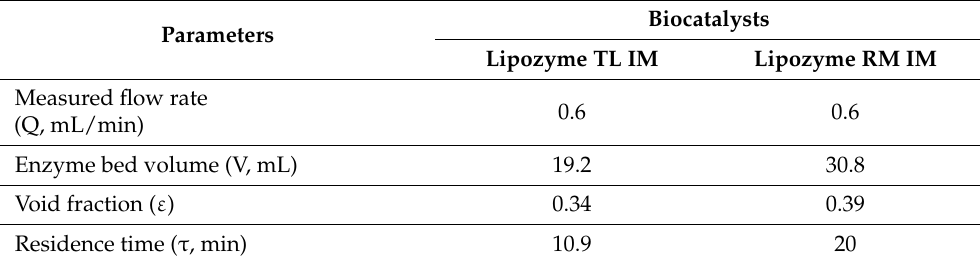
Table 4. Flow rate (Q) and respective residence time ( τ ) estimated for each continuous reactions using Lipozyme TL IM or Lipozyme RM IM as a biocatalyst. Biocatalysts Parameters Lipozyme TL IM Lipozyme RM IM Measured flow rate (Q,